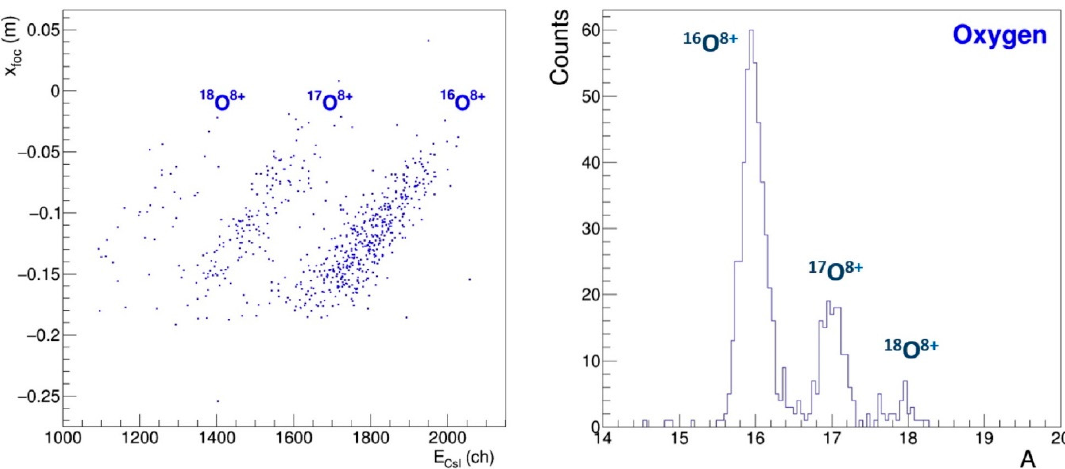
Figure 25. Left : X foc versus E r plot for oxygen isotopes selected by means of the plots of Figure 24. Right : distribution of oxygen ejectiles as a function of their mass number following a linearization and projection procedure.